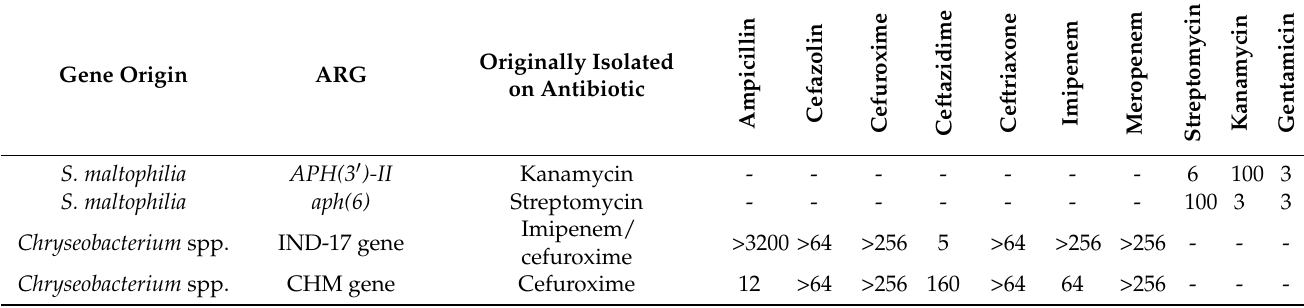
Table 3. Antibiotic resistance of ARGs from S. maltophilia and Chryseobacterium spp. ARGs were cloned to IPTG-inducible pET vectors (pET-218 for aminoglycoside resistance genes and pET-28b